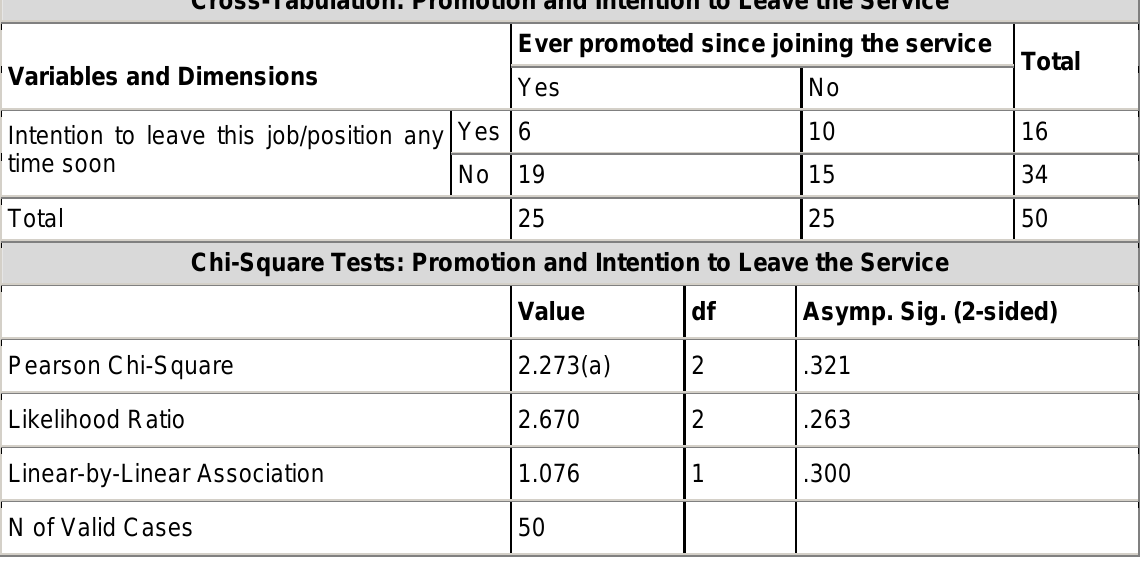
Table 6: Promotion and intention to leave the service Cross-Tabulation: Promotion and Intention to Leave the